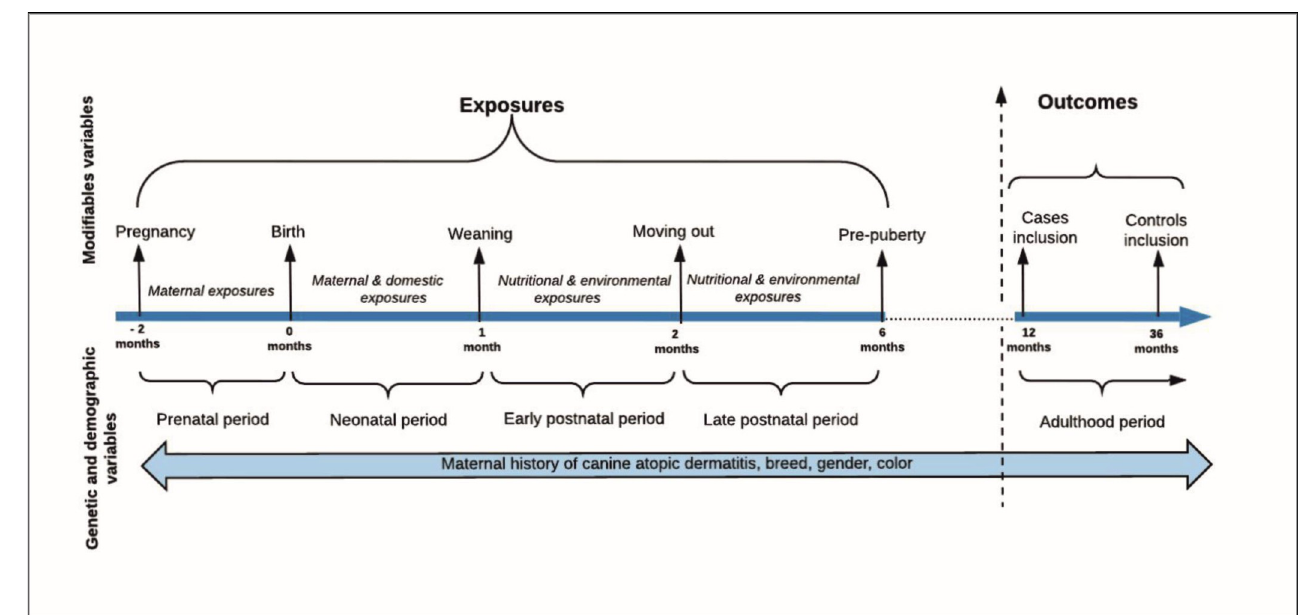
Fig 1. Timeline of the study